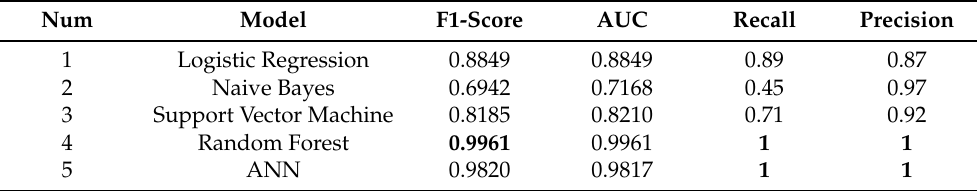
Table 4. F-1 Score, AUC, Recall, and Precision of Machine Learning